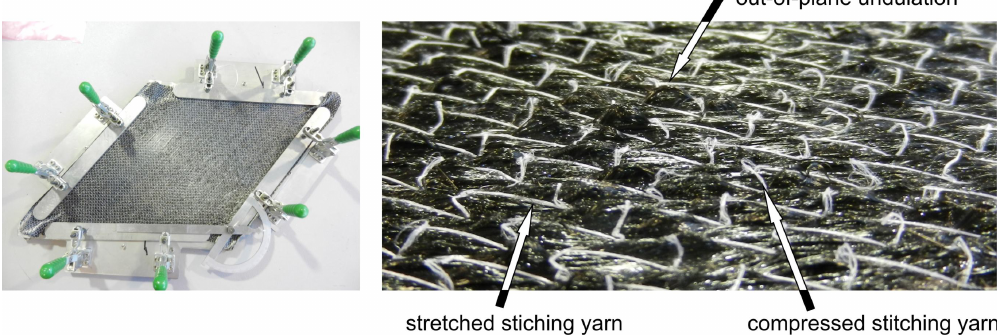
Figure 13. Shear frame with sheared UD-NCF at α = 35.5 ◦ ( left ) and deformation of the stitching yarn with out-of-plane fiber undulation ( right